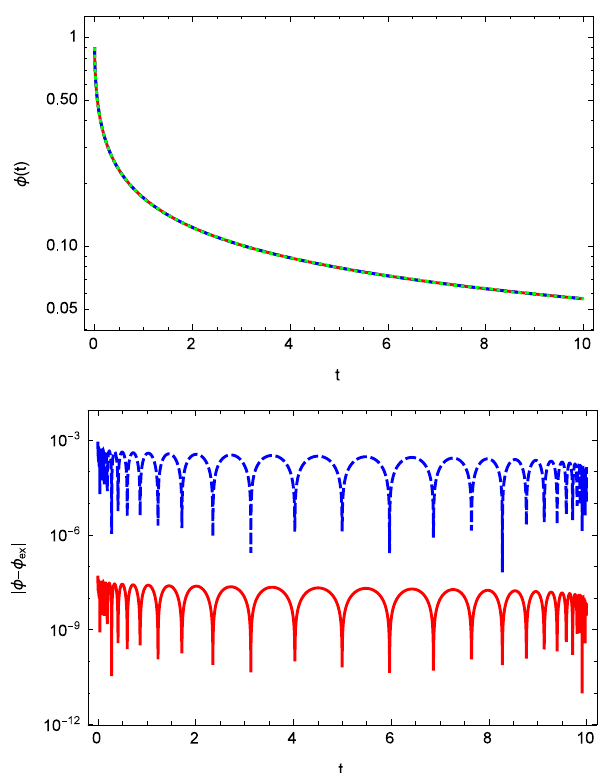
Figure 3. Approximations of the fractional relaxation Equation (84) using the fractional order (cid:12) = 1 = 2 in a Caputo fractional representation. The initial condition and the relaxation = 1 and (cid:28) = 1 = 10 . The solid line represents the analytic solution time (cid:28) was set to ϕ 0 0 0 E ( (cid:0) 10 t ) . The Sinc approximation of the Caputo representation used N = 64 Sinc points. 1